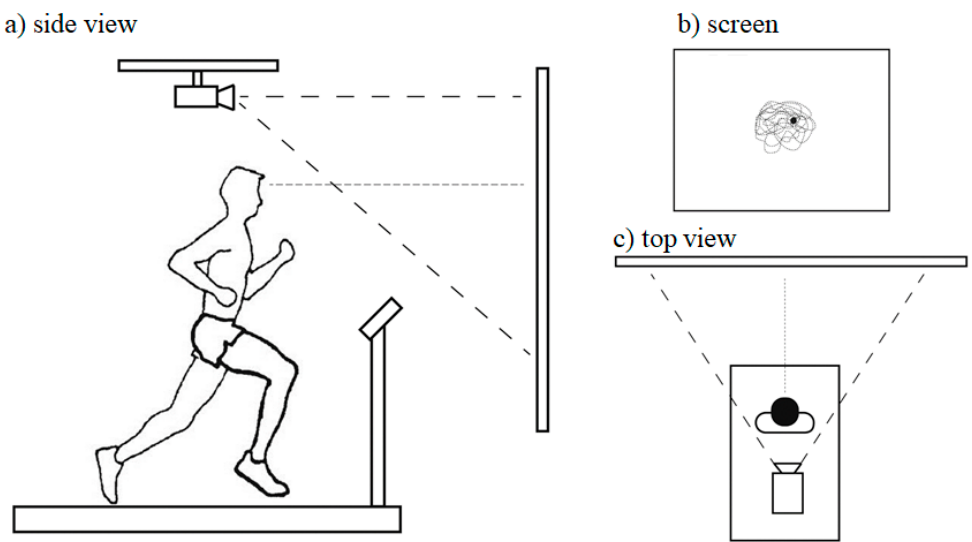
Figure 4. Experimental setup as in Busa et al. [43]. Kinematic data were collected along with tibial and head accelerations. The participants ran at their preferred speed and percentages of their preferred stride frequency. A screen was positioned approximately 2.5 m away from the treadmill center. The dotted line from the participant’s head in ( a ) and ( c ) indicates an imaginary line of a head gaze vector created from the motion capture data of the head. In the visual feedback condition ( b -right), a dot indicating the intersection point of head gaze vector on the screen was displayed while running. In ( b ) the dotted line represents the trajectory of the head gaze point on the screen, this was not displayed during the testing. During the visual feedback condition ( b ), a square box (inset light box) was displayed to indicate the boundary area for the feedback. This box was created by subtending an angle 21 ◦ horizontally and vertically form the center of the treadmill centered at a height of 1.7 m above the treadmill belt.